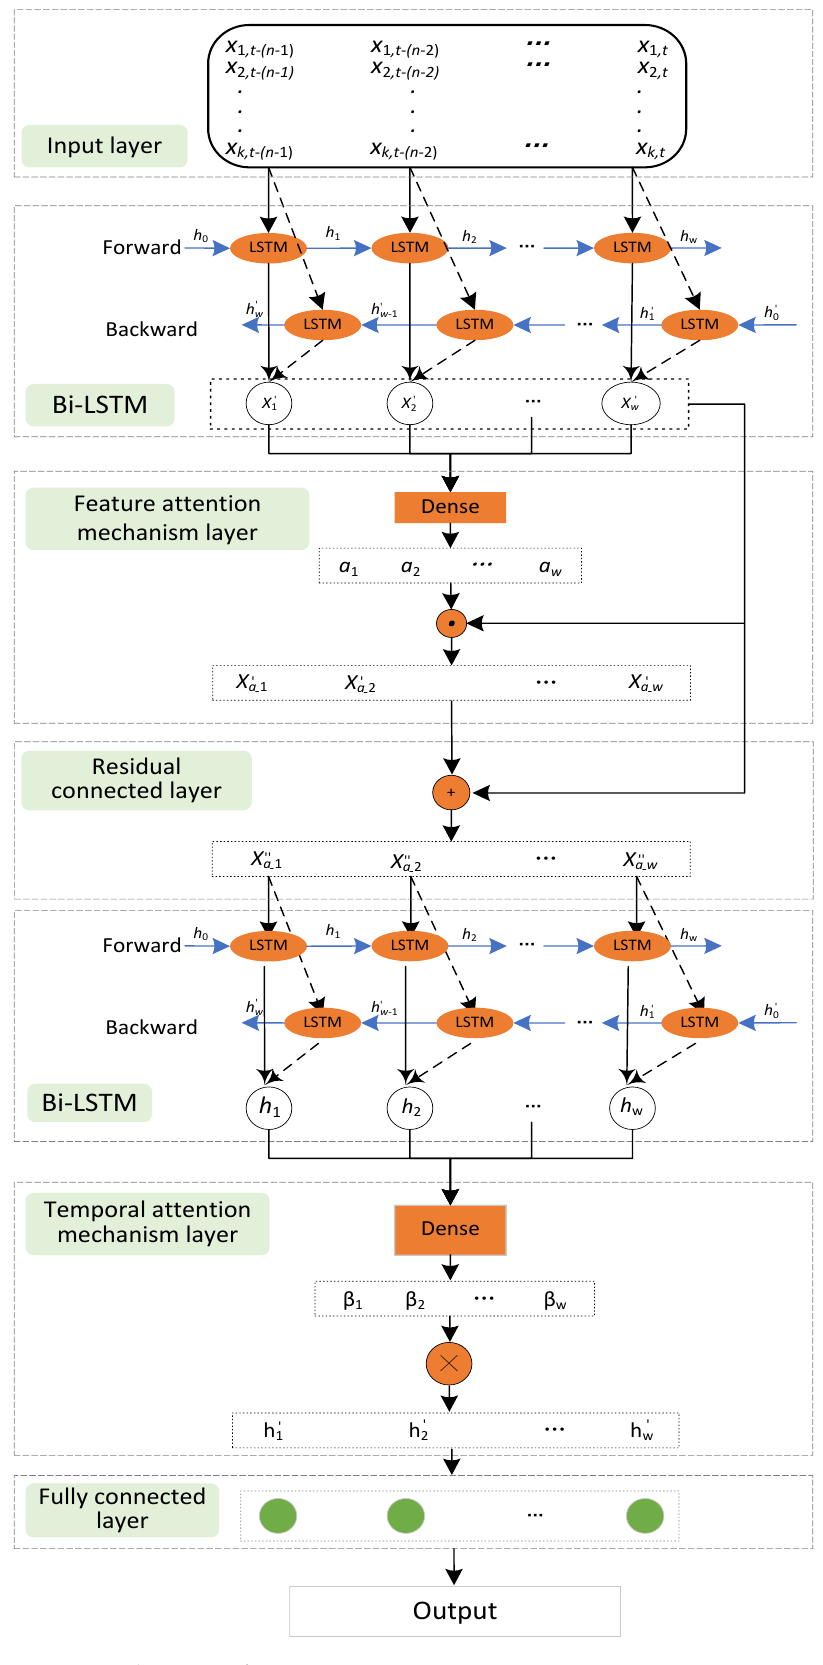
Figure 4. Architecture of Attention-Bi-LSTM PGPM.